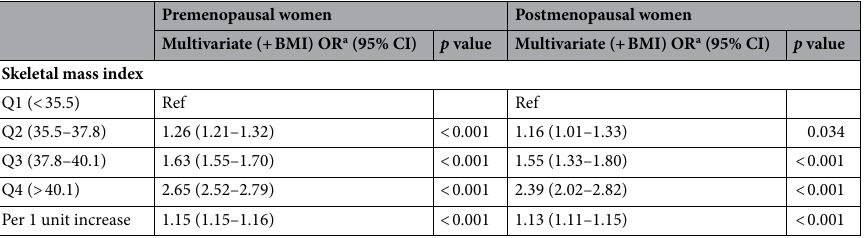
Table 4. Multivariate analysis for the association of higher mammographic density with skeletal mass index after further adjustment for BMI. a Odds ratios (ORs) and 95% confidence interval (95% CI) from the multivariate model including age, body mass index (BMI) and all variables (age at menarche, parous, history of estrogen replacement therapy, calcium level adjusted to albumin) presented in the Table